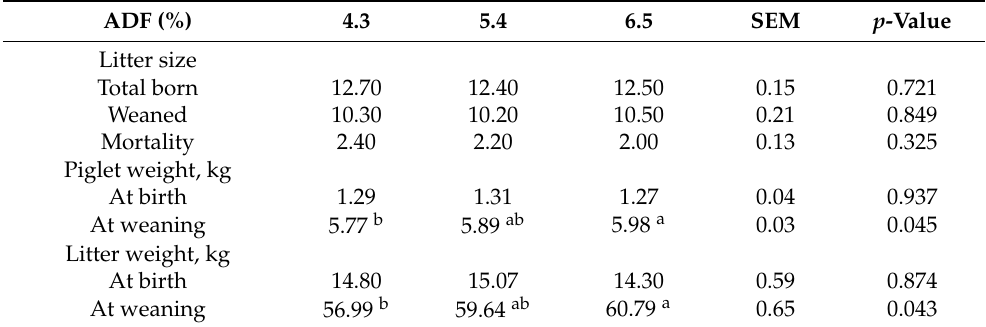
Table 2. Effect of dietary acid detergent fiber (ADF) in gestation diets on litter performance.